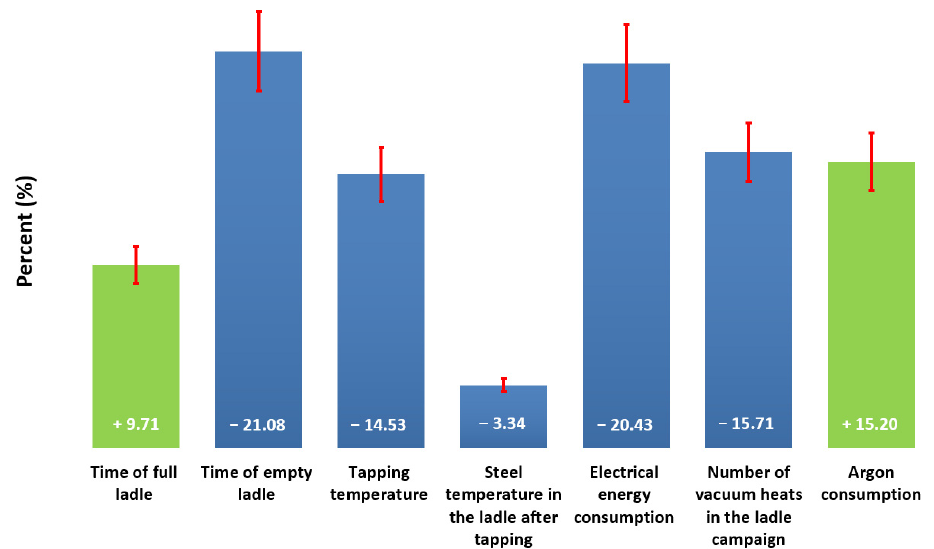
Figure 15. The influence of individual parameters on the life of the lining.